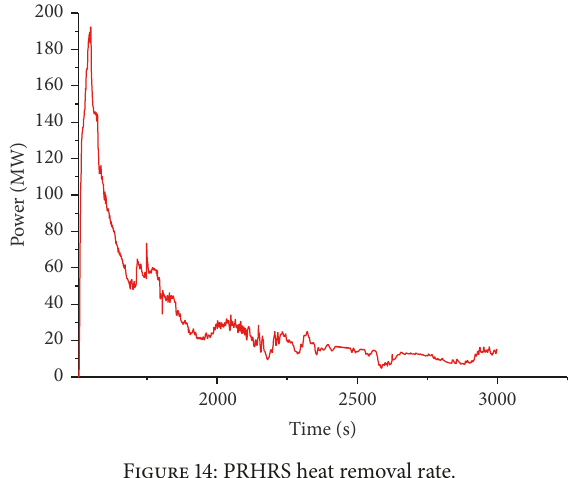
Figure 16: CMT-1 injection rate.